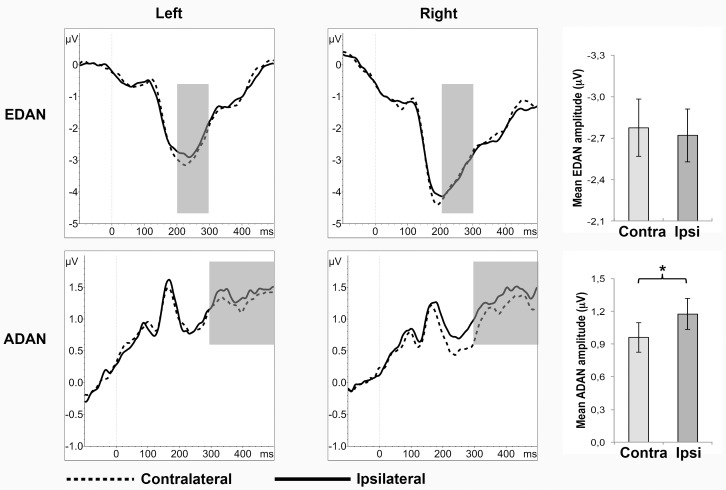
ERP waveforms and mean amplitude ± SE of the EDAN and ADAN for contralateral (contra) and ipsilateral (ipsi) gaze cues.*P < 0.05.